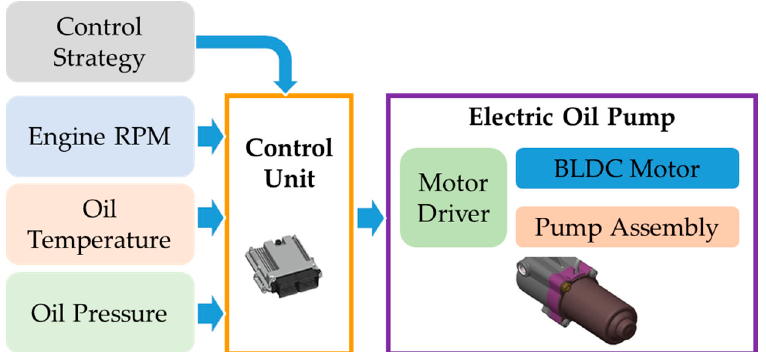
Figure 1. Configuration of the electric oil pump (EOP) system.